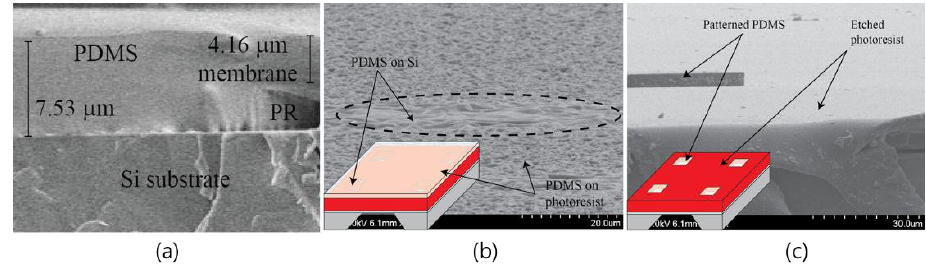
Figure 3. ( a ) Polydimethylsiloxane (PDMS) on Si substrate, ( b ) surface of PDMS membrane, and ( c ) dry etched Si substrate.